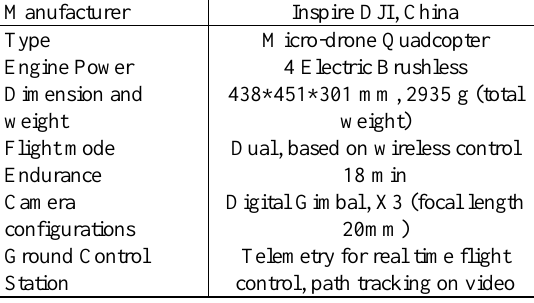
Table 1. Some key specifications of the UAV